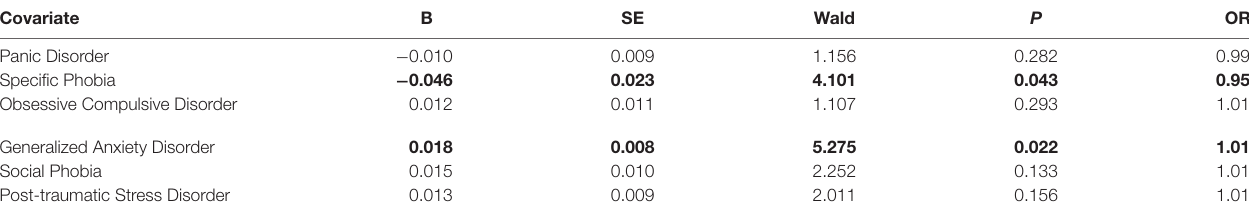
TABLE 4 | Effect of childhood SPD on lifetime diagnosis of specific DSM-IV anxiety disorders. Covariate B SE Wald P OR Panic Disorder − 0.010 0.009 1.156 0.282 0.990 Specific Phobia − 0.046 0.023 4.101 0.043 0.955 Obsessive Compulsive Disorder 0.012 0.011 1.107 0.293 1.012 Generalized Anxiety Disorder 0.018 0.008 5.275 0.015 0.010